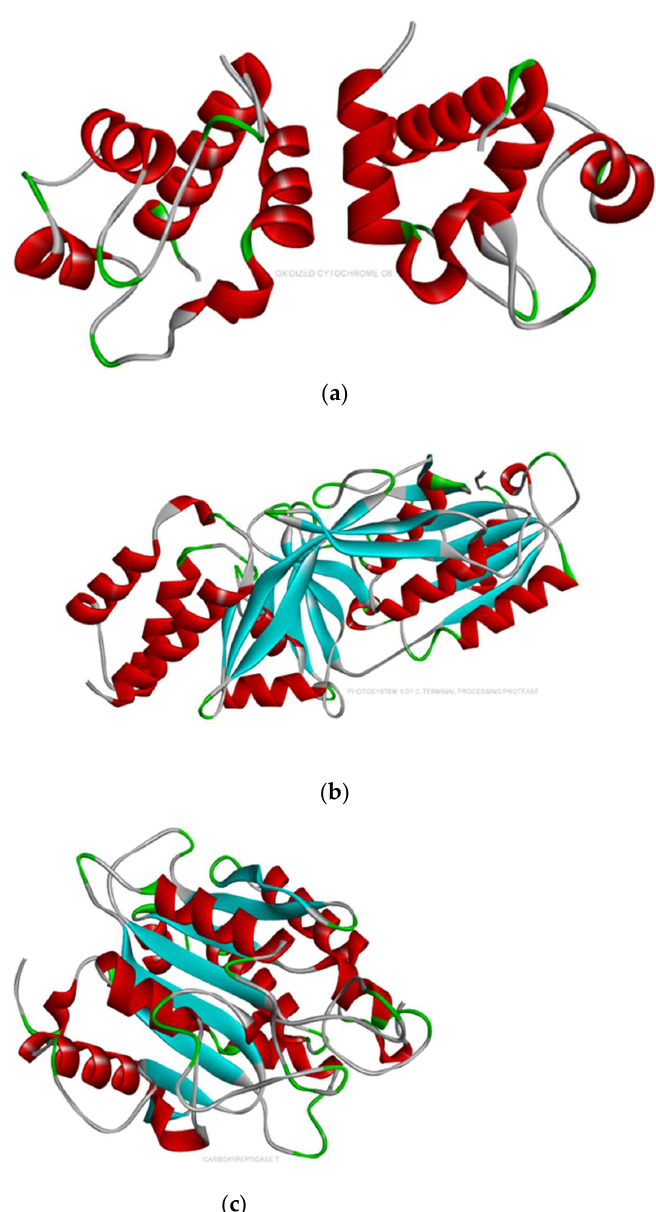
Figure 7. ( a ) c-terminal processing protease (PDB ID: 1FC7); ( b ) oxidized cytochrome c6 from Scenedesmus obliquus (PDB ID: 1C6O); and ( c ) carboxypeptidase t with n-sulfamoyl-l-lysin (PDB ID: 6T9Y) in C.